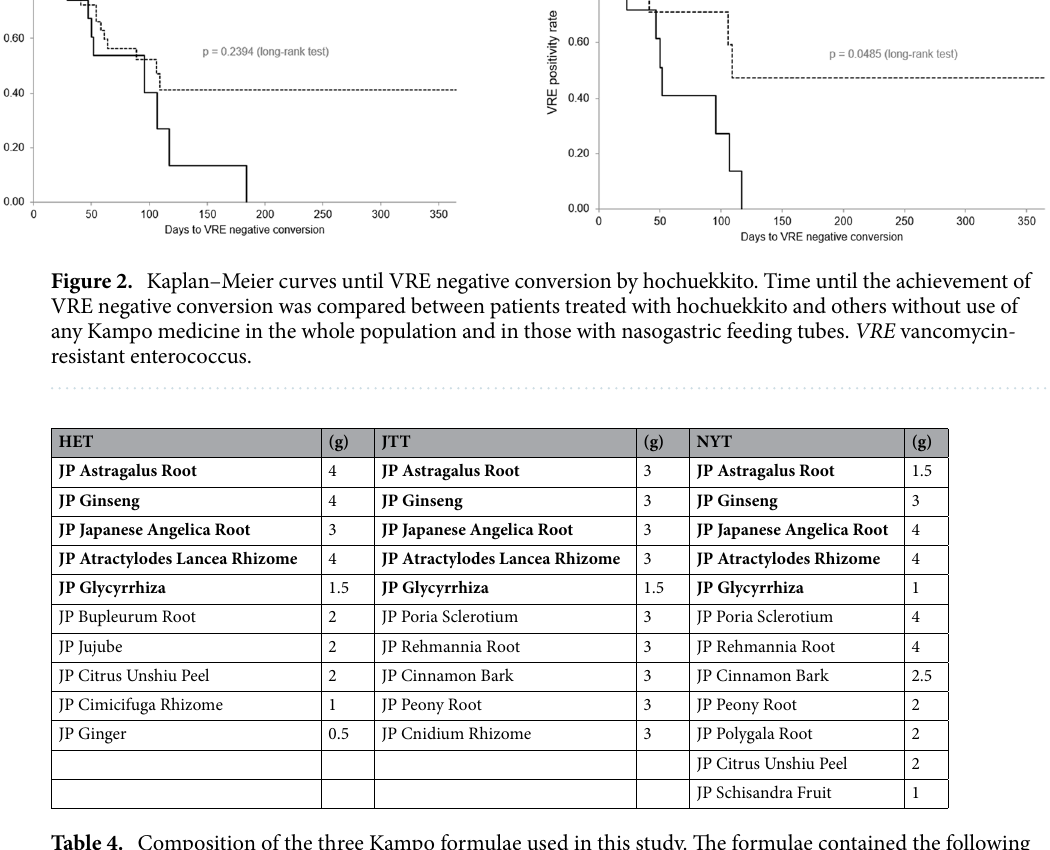
Table 4. Composition of the three Kampo formulae used in this study. The formulae contained the following inactive ingredients: JP Magnesium Stearate and JP Lactose Hydrate. The crude drugs in bold are common in all three formulae. HET is indicated for patients with a delicate constitution, reduced digestive function, and severe fatigability of the limbs: summer emaciation, reinforcement of physical strength after illness, tuberculosis, anorexia, gastroptosis, cold, hemorrhoid, anal prolapse, uterine prolapse, impotence, hemiplegia, and hyperhidrosis. JTT and NYT are indicated for the relief of weakness after recovery from disease, fatigue, malaise, anorexia, perspiration during sleep, cold limbs, and anemia. HET hochuekkito, JTT juzentaihoto, NYT ninjin’yoeito, JP The Japanese